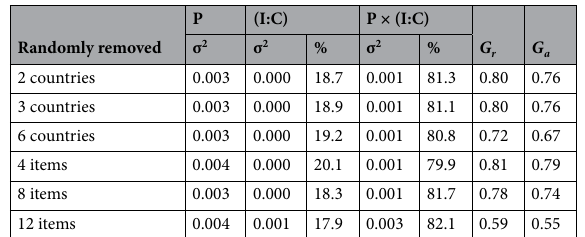
Table 3. D-study reliability estimates and variance components for the Person (P) × Item (I) : Country (C) design including interactions for the Stroke Riskometer with removing some countries or some items at a time.